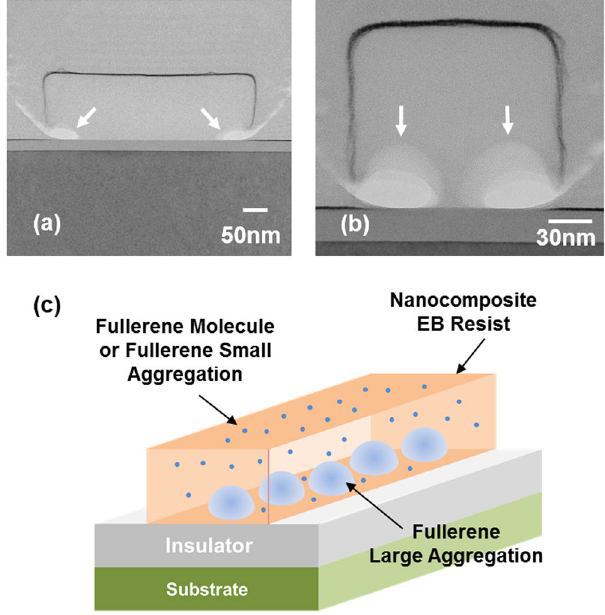
Figure 5. Cross sectional TEM micrograph of ZEP520a containing PCBM for mask patterns of lines and spaces with a line width of ( a ) 500 nm and ( b ) 200 nm. ( c ) Schematic diagram of the predicted distribution of PCBM molecules and aggregations in line pattern with a nanometer width of ZEP520a containing